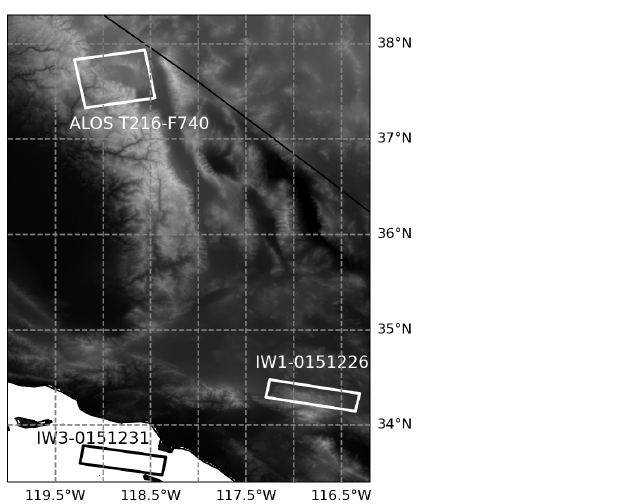
Figure 2. Footprints of the three stacks of SAR metadata that were used in this manuscript overlaid on the 1 km GLOBE DEM—Sentinel-1 burst IW1-0151226 over Big Bear in California, Sentinel-1 burst IW3-015131 over the ocean and ALOS Track 216, Frame 740 over Long Valley in